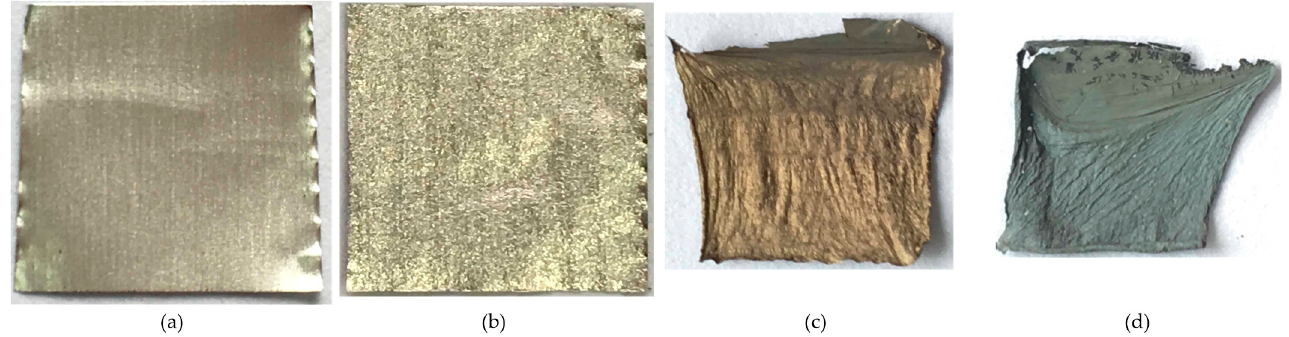
Figure 8. The photos of the aluminum foil substrates without an oxide layer after the CNT formation process at ( a ): 600, ( b ): 700, ( c ): 800, and ( d ): 900 °C.